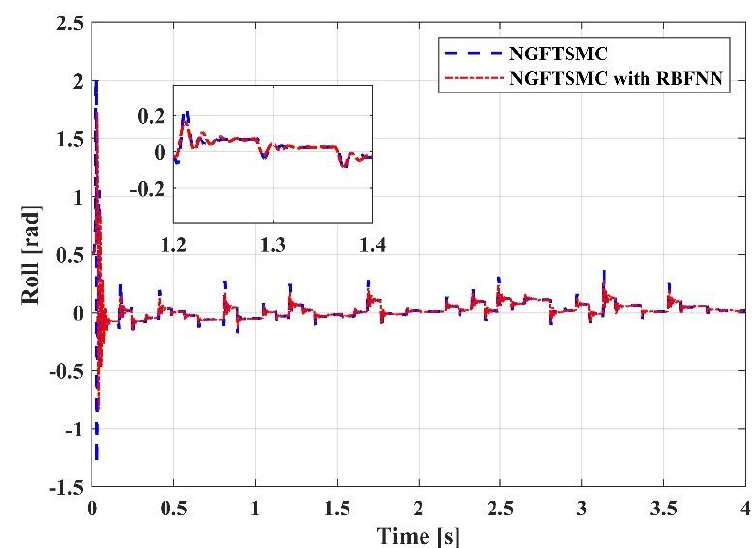
Figure 9. The trajectory tracking results in roll